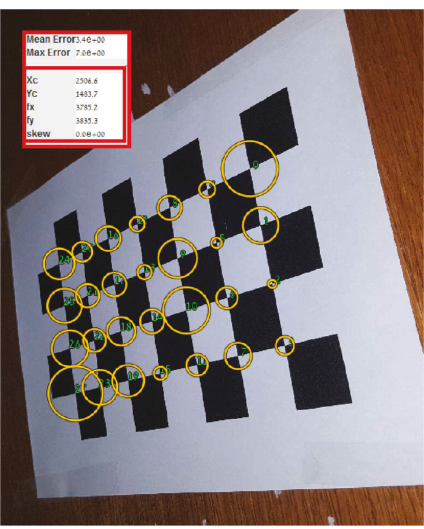
Figure 1: An example of an image (after the calibration process). The intrinsic parameters are marked in red, and the expected accuracy (error) is marked in yellow circles (a larger circle implies a larger expected error).